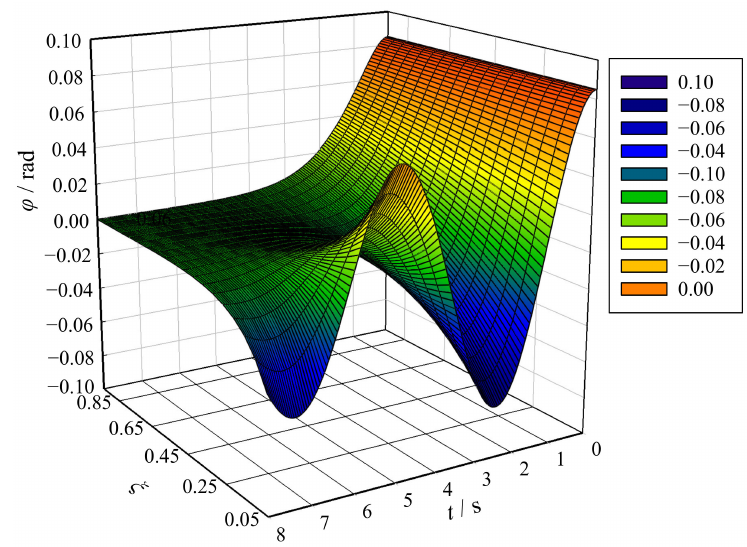
Figure 7. Anti-swaying effect of the under-damping anti-swaying